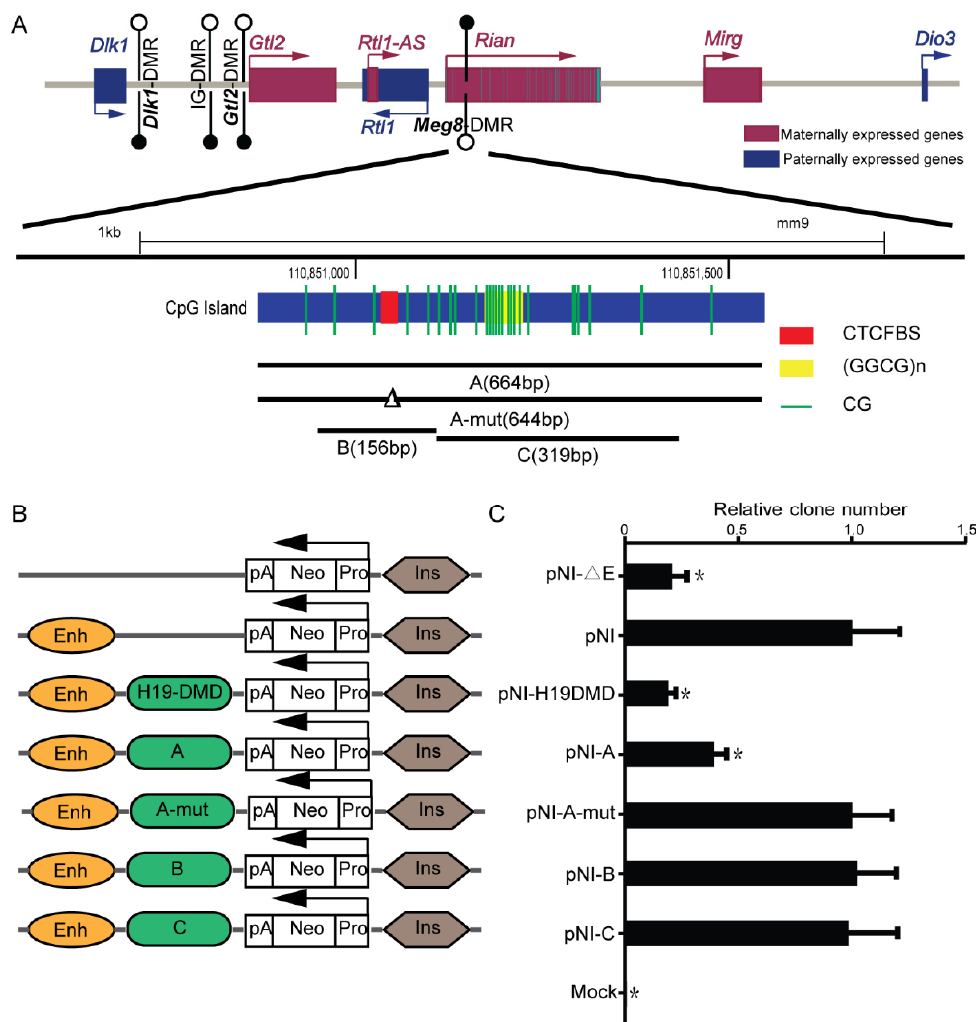
Figure 1. Meg8 -DMR acts as an insulator dependent on the CTCF binding sites. ( A ) Schematic representation of the Dlk1-Dio3 imprinted domain. Maternally expressed noncoding RNAs are shown in red, whereas, protein coding paternally expressed RNAs are in blue. Black and white circles represent methylated and unmethylated. Meg8 -DMR, which is methylated in the maternally inherited chromosome, but unmethylated in the paternally inherited chromosome, is located on the second intron of Rian and contains conserved CTCF-binding sites and GGCG repeats. ( B ) The constructs of the enhancer-blocking assay were prepared and transfected into MLTC-1 cells. Each construct contained a mouse β -globin 3 ′ HS2 enhancer element and a human A γ -globin promoter directing transcription of a neo reporter (Neo), and various test fragments were inserted between them. ( C ) The colony number for each test is expressed relative to the number observed with the control plasmid (PNI). Mock is the blank control group. Error bars, mean ± SEM. n = 3. p values were calculated using t -test. * p < 0.05.